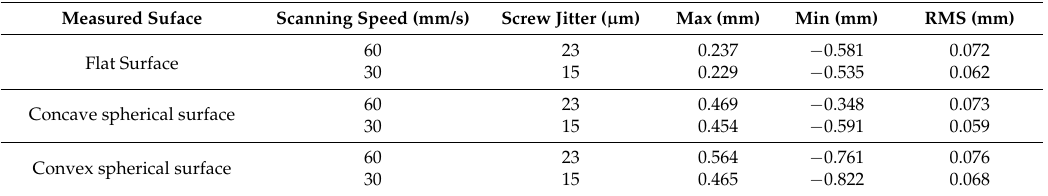
Table 2. Statistical results of the deviations.